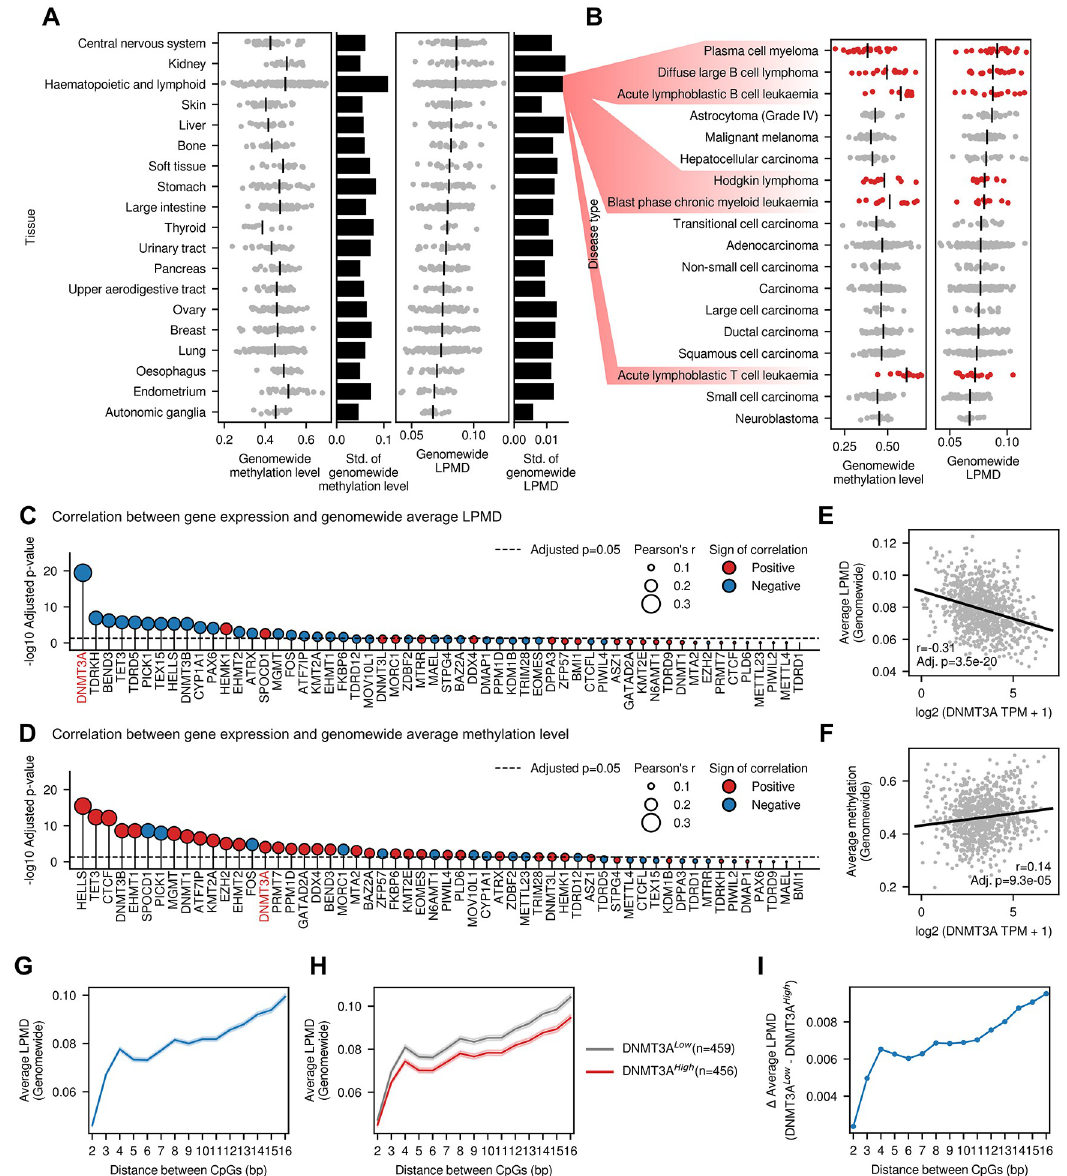
Fig 3. Characteristics of LPMD across 928 cancer cell lines. (A) Genomewide average methylation levels and LPMD levels grouped by tissue types. Black vertical lines denote groupwise average levels of methylation and LPMD levels. Black horizontal bars on the right side denote the standard deviation of corresponding values. (B) Genomewide average methylation levels and LPMD levels grouped by disease types. Disease types from haematopoietic and lymphoid tissues are highlighted in red. (C, D) Correlation between mRNA expression and (C) genomewide average LPMD or (D) genomewide average methylation level. Genes are ranked according to the p-values of the corresponding correlation coefficients. P-values were adjusted using Benjamini-Hochberg procedure. (E, F) Correlation between DNMT3A expression and (E) genomewide average LPMD or (F) genomewide average methylation level. (G, H) Trends of fixed-distance average LPMD values. Shades denote 95% confidence interval. In (H), Cell lines were divided into two groups based on the median DNMT3A expression. (I) Difference of fixed-distance average LPMD values between DNMT3A High and DNMT3A Low groups.